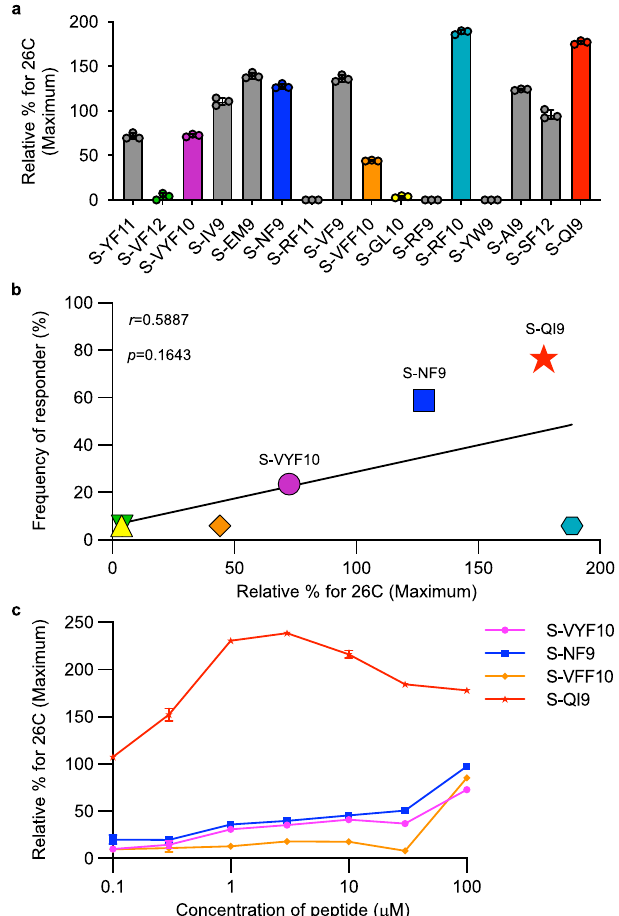
Fig. 4 | Binding of HLA-A*24:02-restricted spike epitope peptides to HLA- A*24:02. a Binding of 16 HLA-A*24:02-restricted SARS-CoV-2 epitope peptides to HLA-A*24:02 was measured by HLA class I stabilization assays using RMA-S-A2402 cells and a peptide concentration of 100 μ M. The colored bar indicates T cell epi- topes invaccinated, HLA-A*24:02 + individuals. Relative % for 26°C(Maximum) was calculatedasshowninMethods.ThedataarepresentedasthemeanandSD( n =3). b Correlation between the binding of 7 epitope peptides to HLA-A*24:02 and fre- quencyof responders to these peptides. Statistical analyses were performed using two-tailed Pearson ’ s correlation test. c Binding of 4 epitope peptides to HLA- A*24:02 was analyzed by HLA stabilization assays using peptide. concentrations rangingfrom0.1to100 μ M.Thebindingresultsin a , c areplottedasthe%increase in surface HLA-I expression relative to expression at 26°C and calculated as the ratioofthemean fl uorescenceintensity(MFI)ofpeptide-pulsedRMA-S-A2402cells compared withthatofthecontrol(non-peptide-pulsed)cellsat26°C.Thedataare presented as the mean and SD ( n =3). Gating strategy in fl owcytometry analysis is shown in Supplementary Fig. 3a. Source data are provided as a Source Data fi